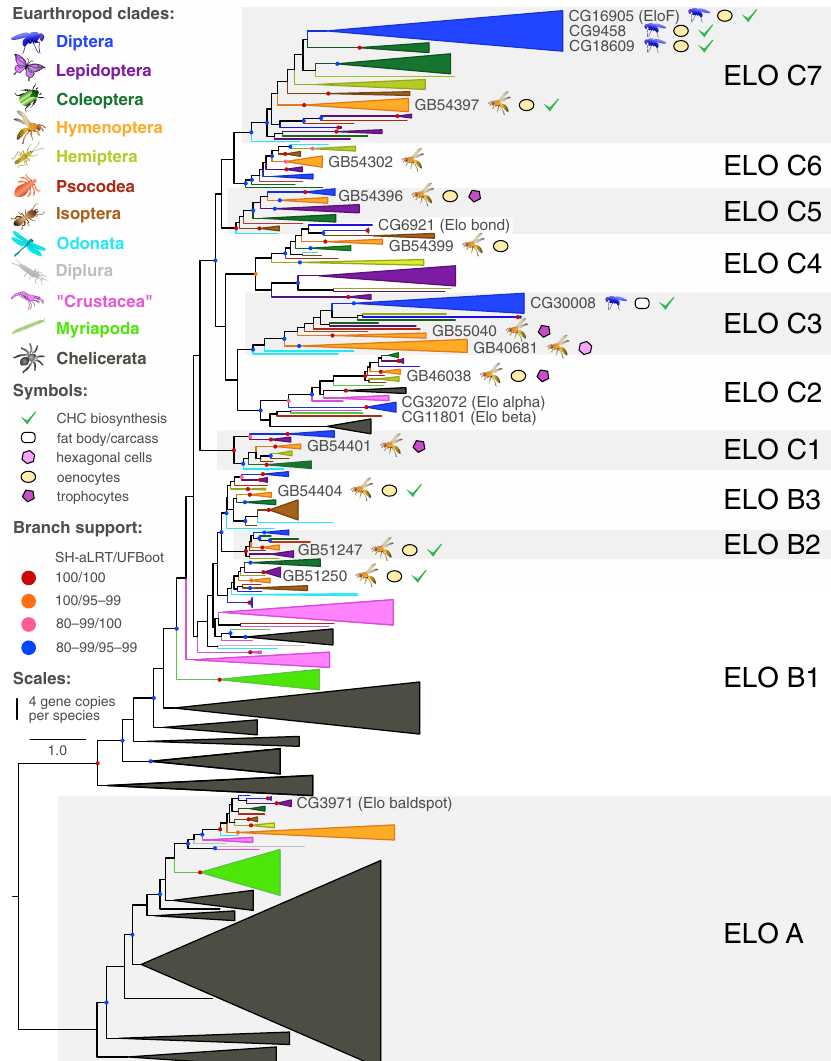
Fig. 2 Gene tree of fatty acid elongases from 37 species of Euarthropoda showing copy numbers and involvement of genes in CHC biosynthesis. Branch support was calculated from ultrafast bootstrap (UFBoot2) replicates (in %) and Shimodaira-Hasegawa approximate likelihood ratio tests (SH-aLRT in %). Supported branches are represented by a color circle, whereas those with SH-aLRT<80% and UFBoot<95% do not have a circle. The width of each clade represents the number of gene copies per species (single copies represented by a